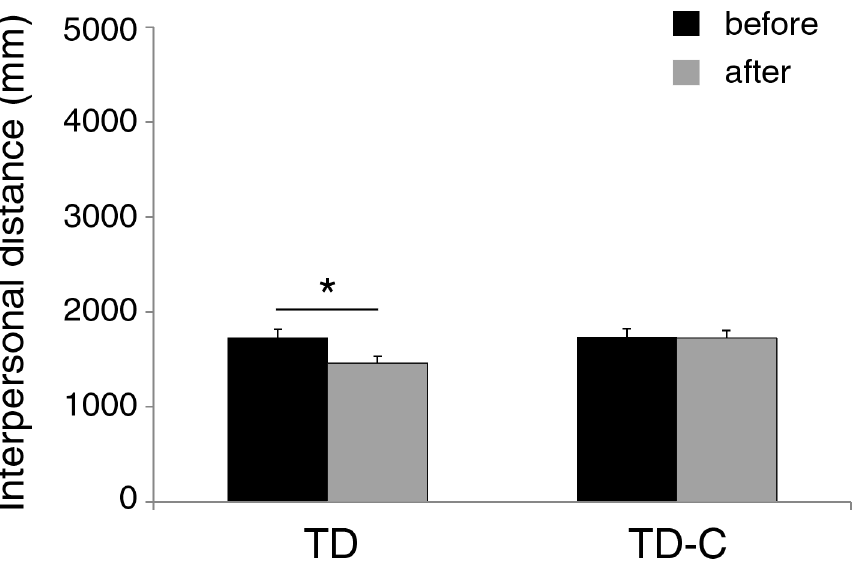
Figure 4. Mean preferred distance from the confederate in two groups of children with typical development before and after a time interval during which the confederate interacted (TD group), or not (TD-C group), with the participant. Asterisk indicates significant comparison (p < 0.05). Error bars denote